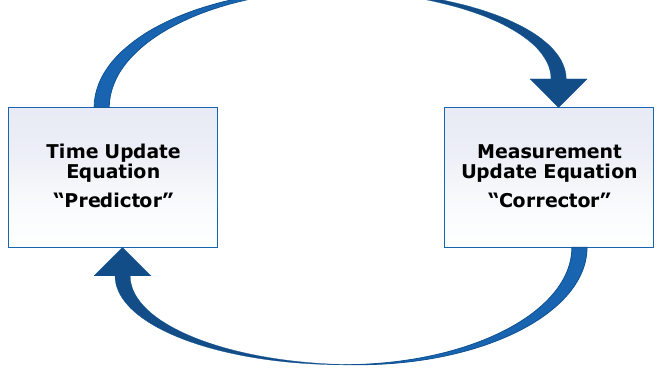
Figure 4. Updating of Kalman Filter.